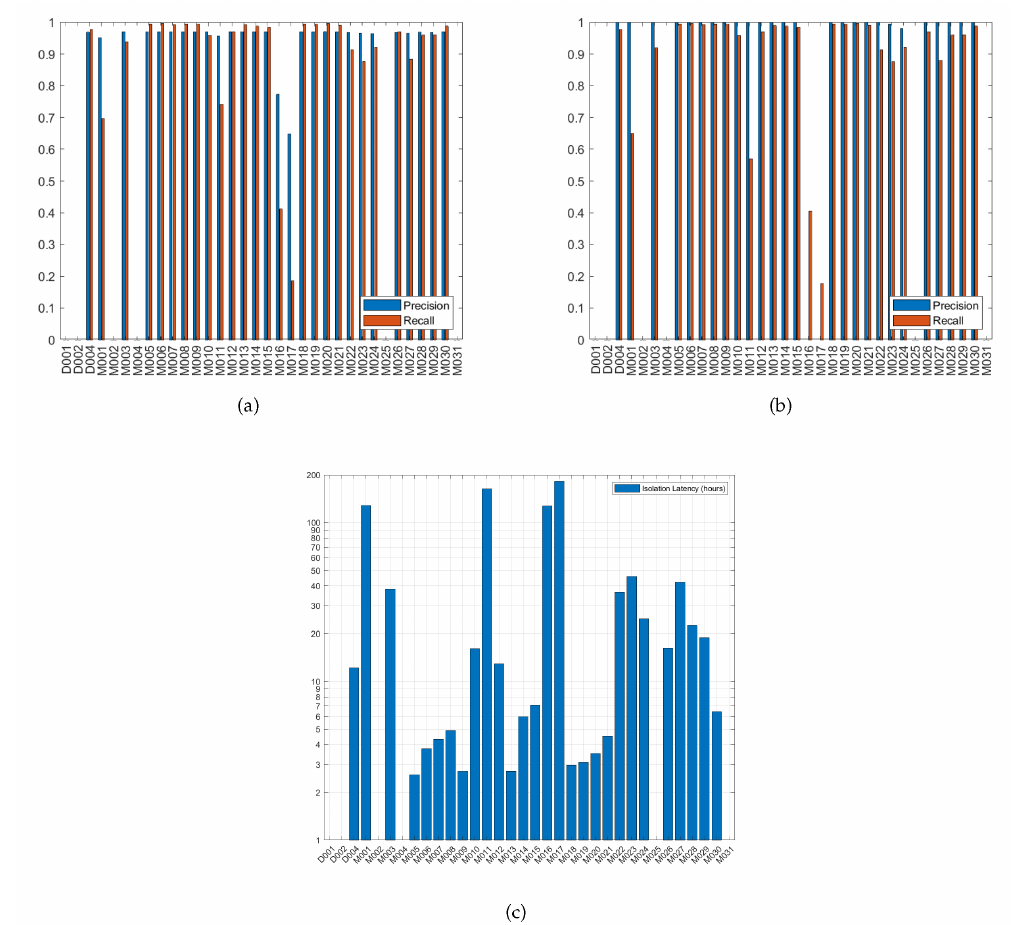
Figure 9. Fail-Stop Failure: ( a ) Precision and recall of failure detection. ( b ) Precision and recall of failure isolation. ( c ) Failure isolation